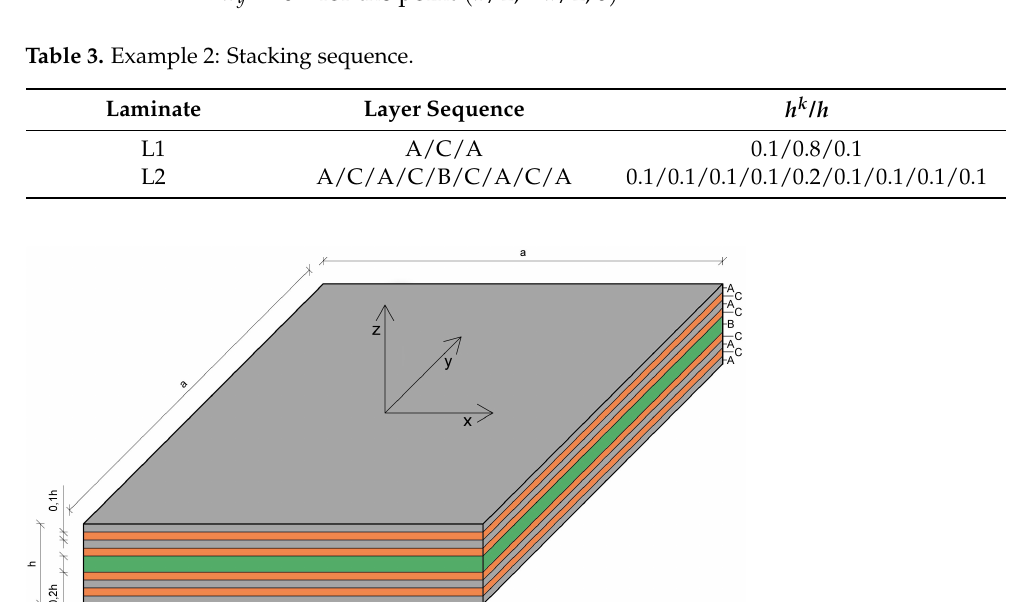
Figure 7. Example 2: Construction of the nine-layered